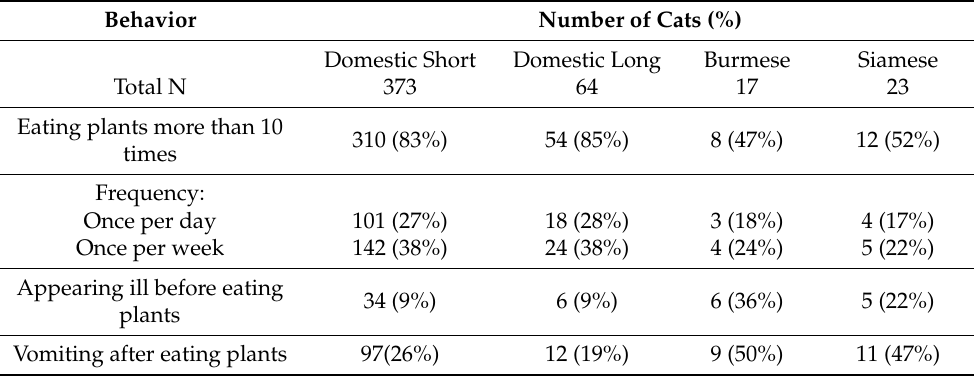
Table 3. Frequency of eating plants and behaviors prior to and following eating plants in short-haired and long-haired cats from Survey 2. Cats designated as domestic short hair are compared with domestic long hair and Burmese with Siamese. Behavior Number of Cats (%) Domestic Short Domestic Long Burmese